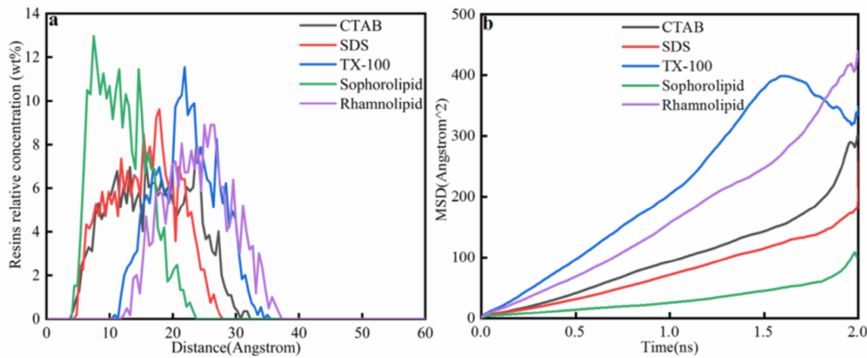
Figure 14. ( a ) Resins relative concentration; ( b ) Mean square